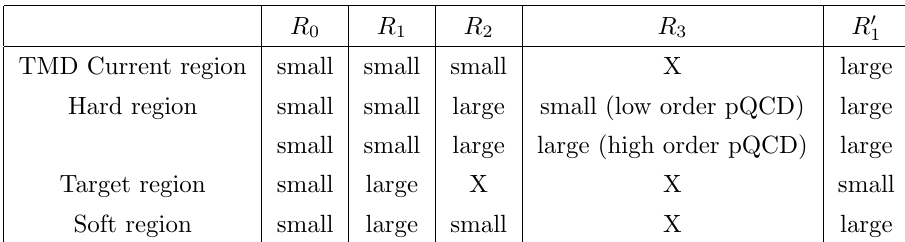
Table 1 . Examples for sizes of ratios corresponding to particular regions of SIDIS. The \X" means \irrelevant or ill-de(cid:12)ned." This ranking should be viewed as schematic since \small" and \large" need to be de(cid:12)ned quantitatively and can in general be scale-dependent.